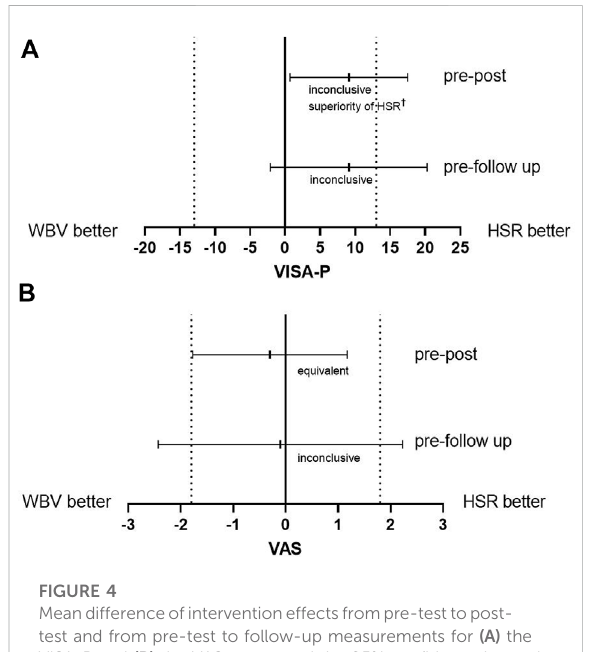
FIGURE 4 Meandifferenceofinterventioneffectsfrompre-testtopost- test and from pre-test to follow-up measurements for (A) the VISA-P and (B) the VAS scores and the 95% con fi dence intervals. Dotted lines represent the equivalence margin. HSR = heavy slow resistance training; WBV = whole body vibration training. † The result is inconclusive regarding possible inferiority of magnitude equivalence margin or worse since the con fi dence interval includes the equivalence margin (Piaggio et al.,